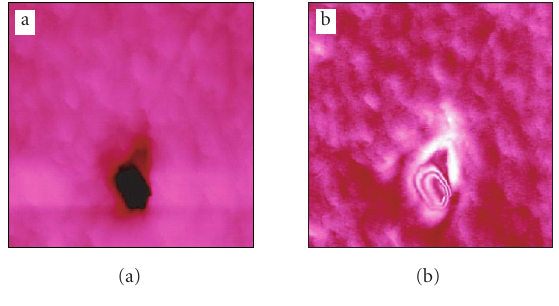
Figure 22: Higher-resolved (pixel size 5nm) 2.5 μ m AFM (a) and SNOM image (b) of the lysosome and adjacent organelles in an un- stained cryomicrotome cut of a shrimp eye in the peripheral region.